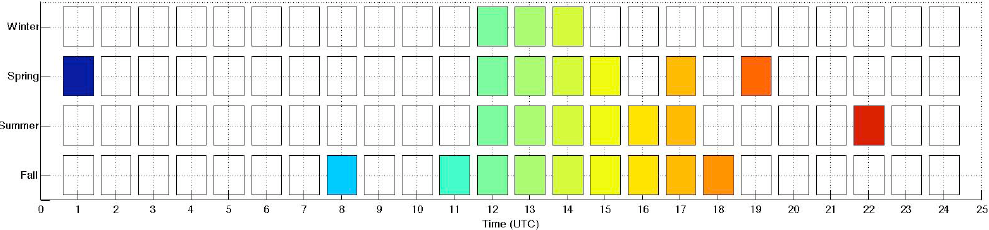
Fig. 7. Result of the Mann and Whitney U test applied on the positive cluster ion mode diameter from event and non-event days. Squares are colored when the null hypothesis of samples with different medians cannot be rejected at the threshold of